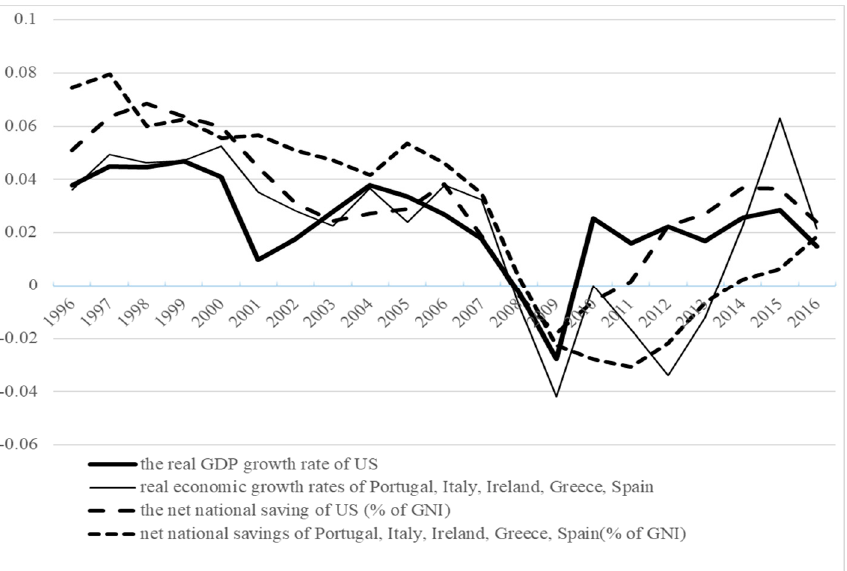
Figure 2. Real Economic Growth Rates and Net National Saving Rates, Data source: WDI(2010 = 100